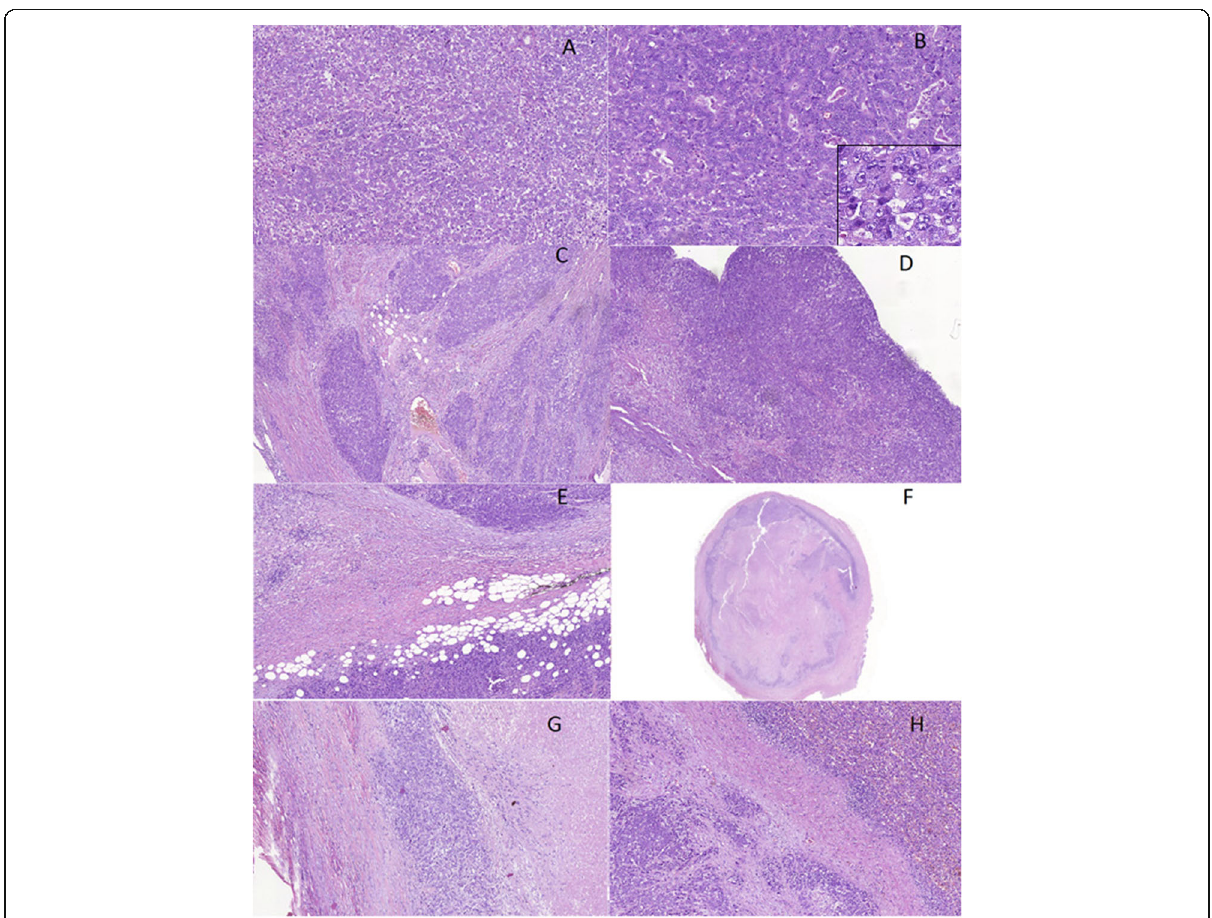
Fig. 3 a . Infiltration of the renal parenchyma by a solid high grade adenocarcinoma; b . Rare tubular structures with eosinophilic secretions (inlet: high power view of the glandular structures); c . Invasion of the renal sinus; d . Invasion of the renal pelvis; e . Invasion of the perirenal fat; f . Panoramic view of the ureter, showing diffuse infiltration by a highly necrotic neoplasm; g . High power view of the ureteral wall with infiltration by a high grade adenocarcinoma; h . Infiltration of the splenic capsule by high grade